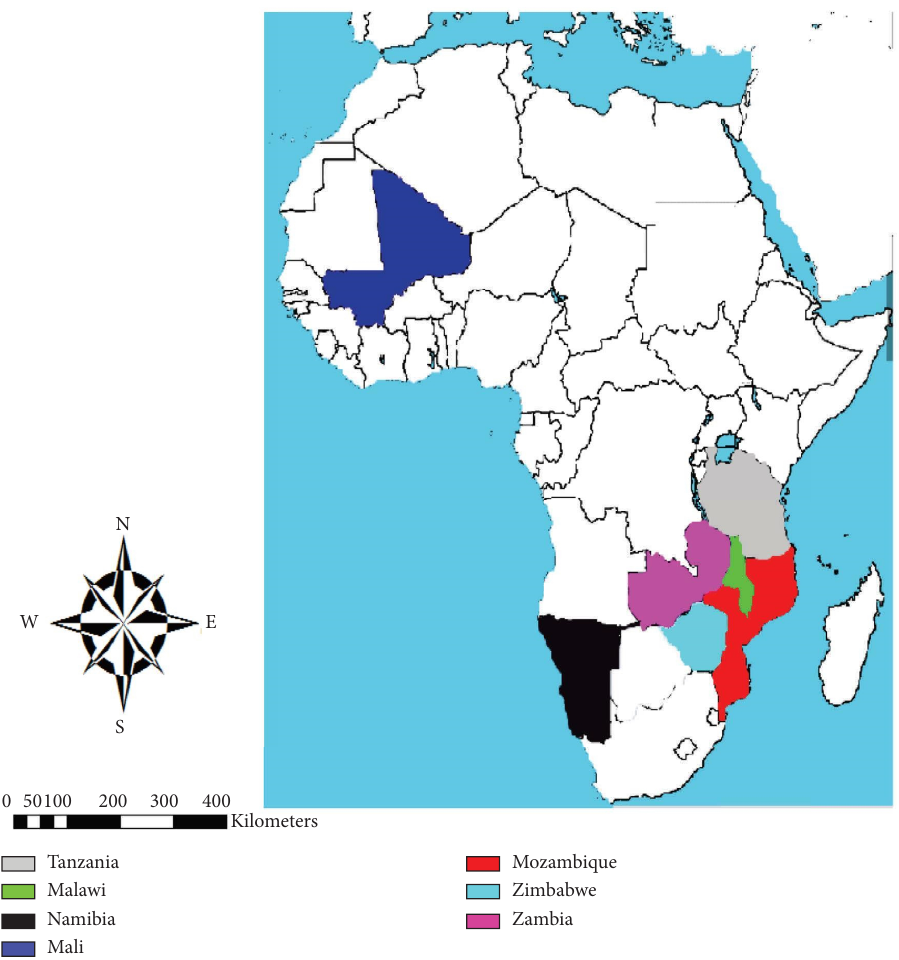
Figure 1: Map of Africa showing countries where Sclerocarya birrea seed was collected.